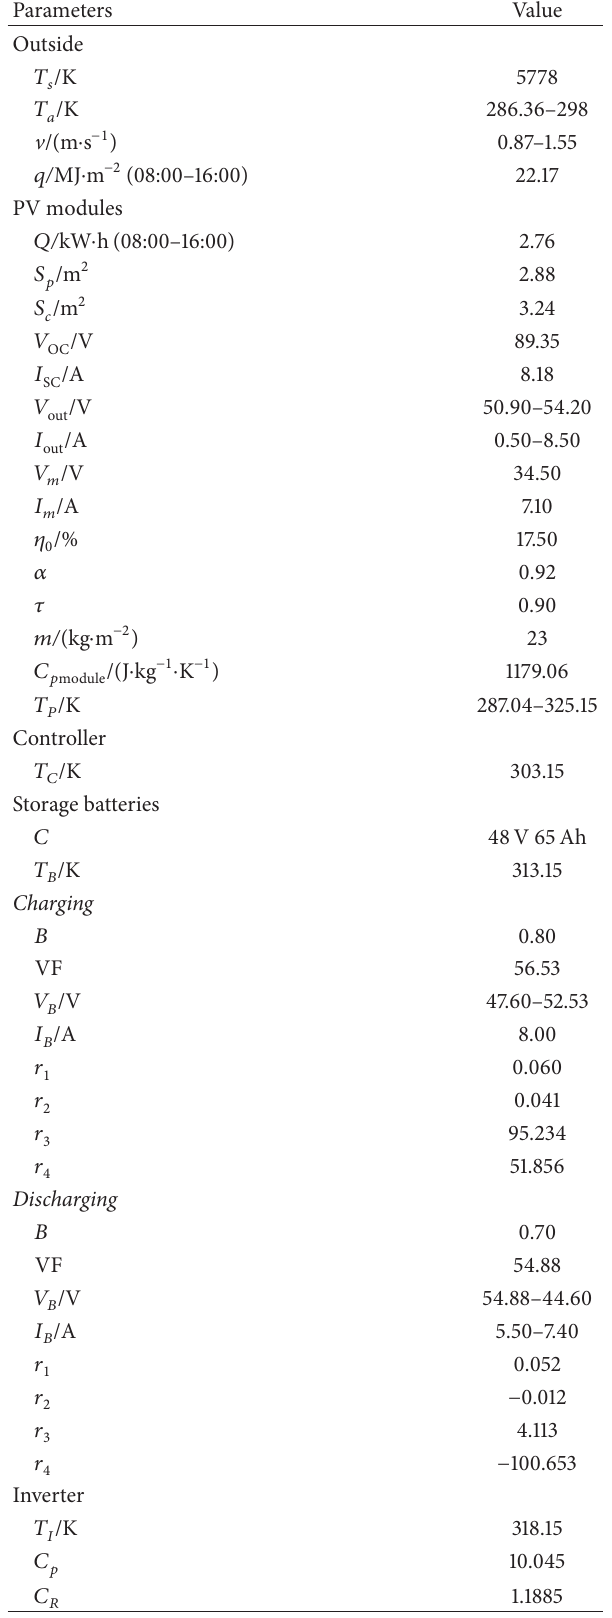
Table 3: Related parameters of ISACS driven by